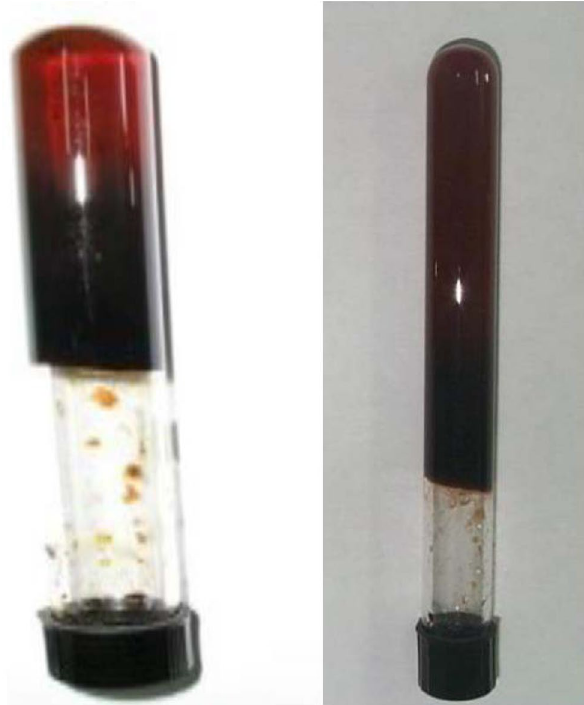
Fig. 5 The cross-linked polymer gel